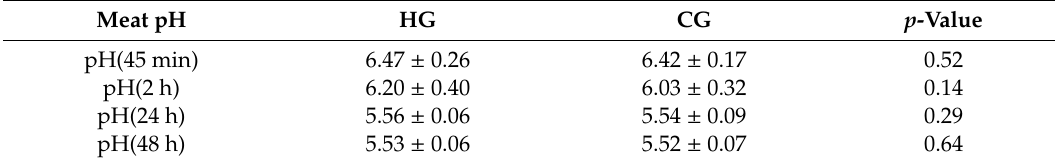
Table 7. E ff ect of gentle handling on meat pH of finishing pigs (mean ± standard deviation) ( p <